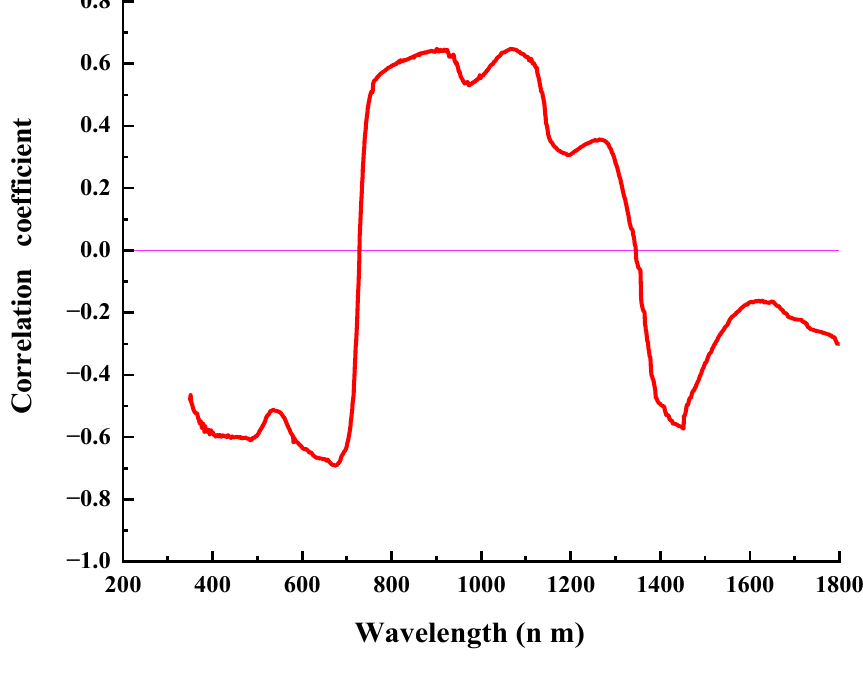
Figure 4. The correlation between the canopy spectrum and the leaf area index. The results of the correlation analysis between the canopy first-order differential spectrum and the LAI are shown in Figure 5. The canopy first-order differential spectrum positively correlated with the LAI at approximately 470 nm, and the correlation was relatively high (0.7868). The correlation coefficient at 487 nm was 0.8325, and there was a significant negative correlation at approximately 510 nm. This correlation coefficient was lower than that at 487 nm. At 796 nm, the canopy first-order differential spectrum positively correlated with the LAI with a relatively high value of 0.8598. The first-order differential spectrum of the canopy strongly positively correlated with the LAI at 490 nm, 780 nm, 1030 nm, 1200 nm, and 1425 nm and strongly negatively correlated at 620 nm, 1150 nm, 950 nm, and 1340 nm, indicating that the first-order differential spectrum of the canopy is between the LAI. There are more sensitive bands, and the first-order differential spectrum of the canopy can significantly enhance the spectral information of cotton LAI. The most sensitive band between the first-order differential spectrum of canopy and LAI was at 1142 nm, with the highest correlation of 0.9236. Differential spectroscopy can eliminate the influence of soil background, atmospheric scattering, and absorption on vegetation spectra, which enhances the correlation between spectral reflectance and cotton LAI, and thus improves the accuracy of the